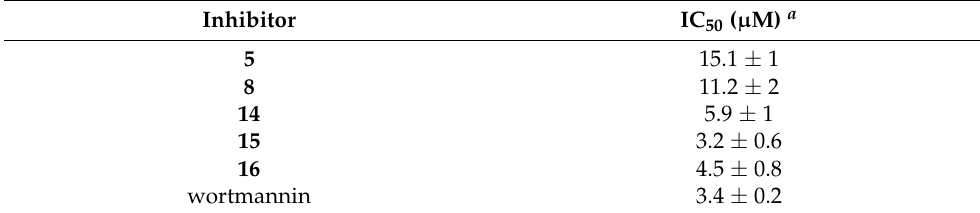
Table 3. Antiproliferative activities of the PIM1 inhibitors in T47D cell